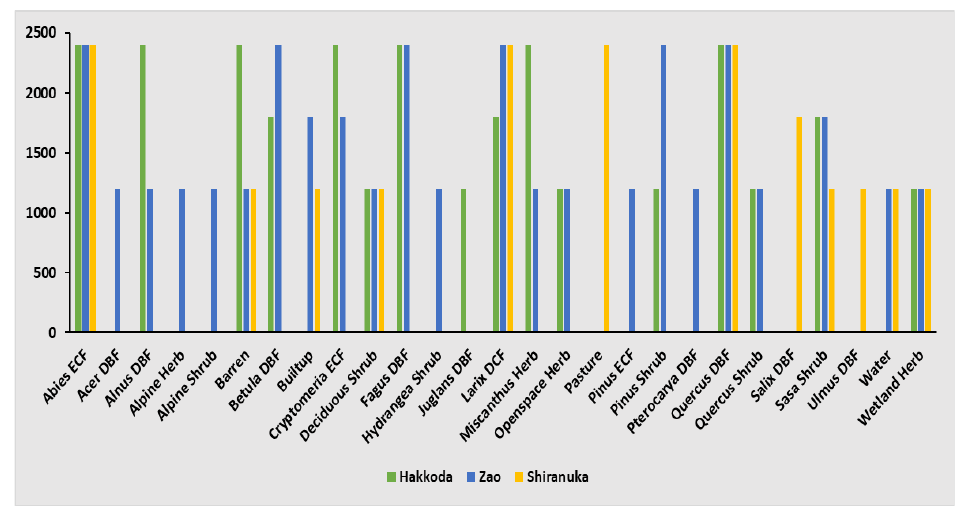
Figure 2. Distribution of the ground truth data size for each site.